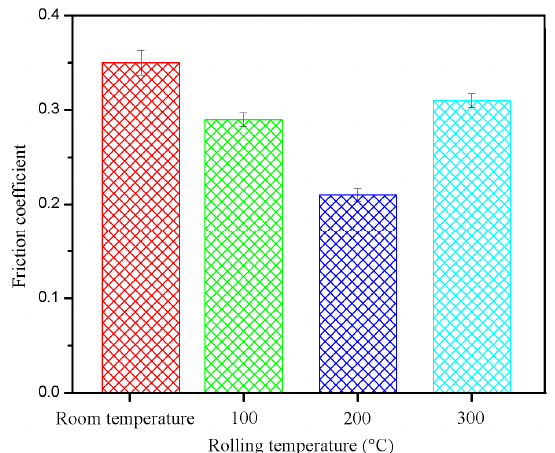
Figure 6. Friction coefficient of the densified area of the samples prepared with different pre-heated temperatures.